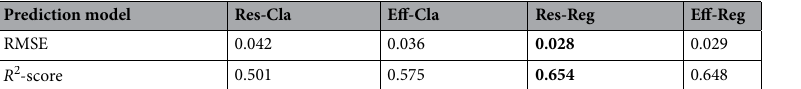
2 Table 2. MSE and R -score of considered BCVA estimation schemes where the highest performance is highlighted in bold